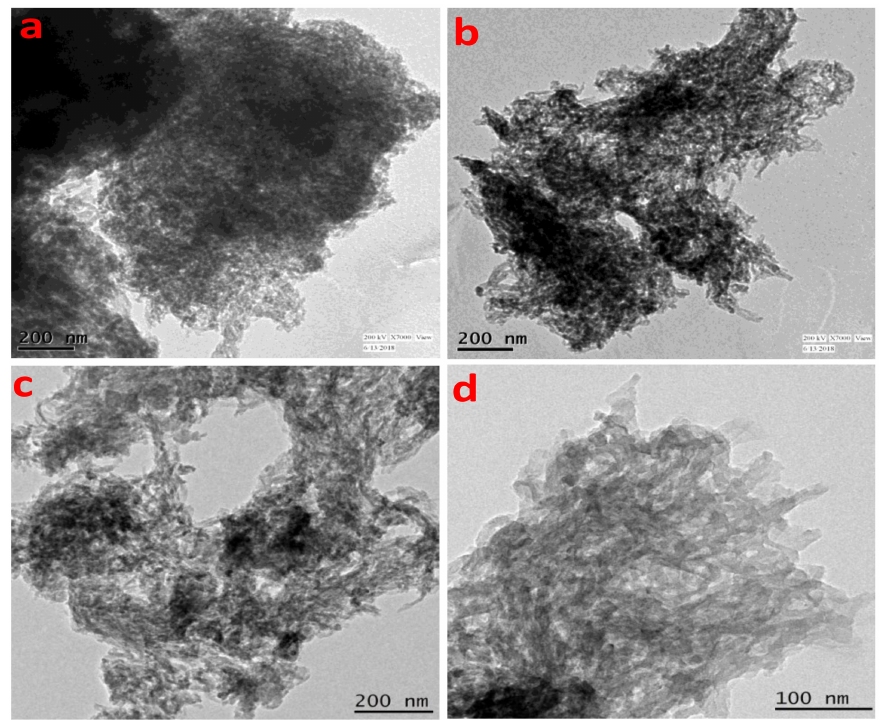
Figure 2. HRTEM images of TrzTFPPOP before ( a , b ) and after ( c , d ) cell treatment.